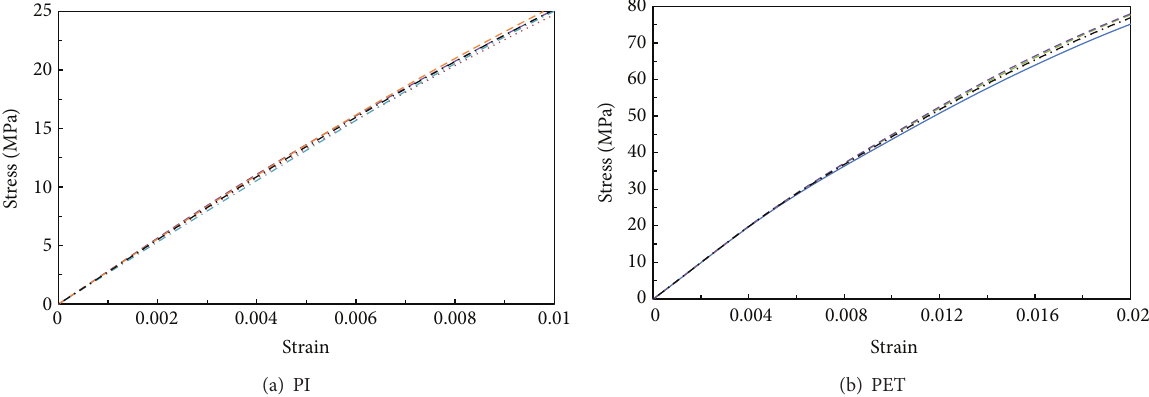
Figure 8: Tensile stress-strain curve for the PI and PET.